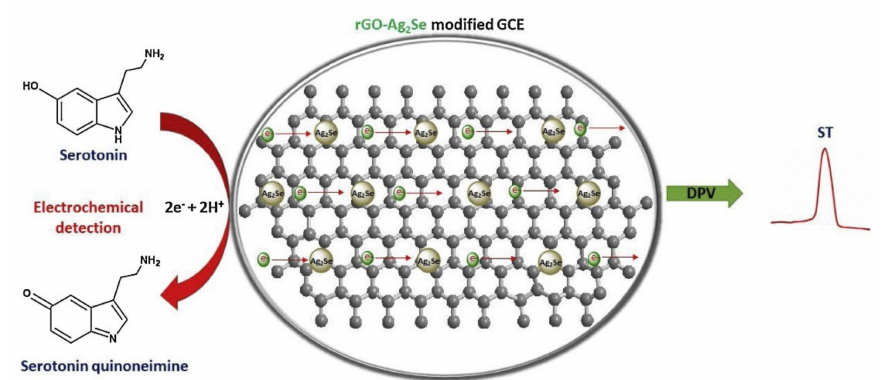
Figure 7. Mechanism of serotonin electrochemical detection. Reprinted from [109] with permission of